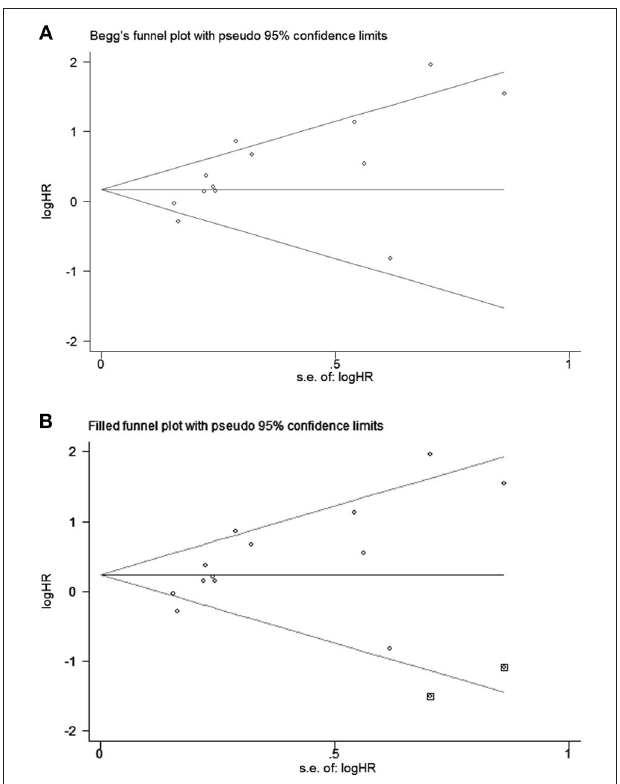
FIGURE 5 | Begg’s funnel plots for publication bias of PD-L2 on OS. (A) Publication bias for OS without trim and fill; (B) publication bias for OS with trim and fill.